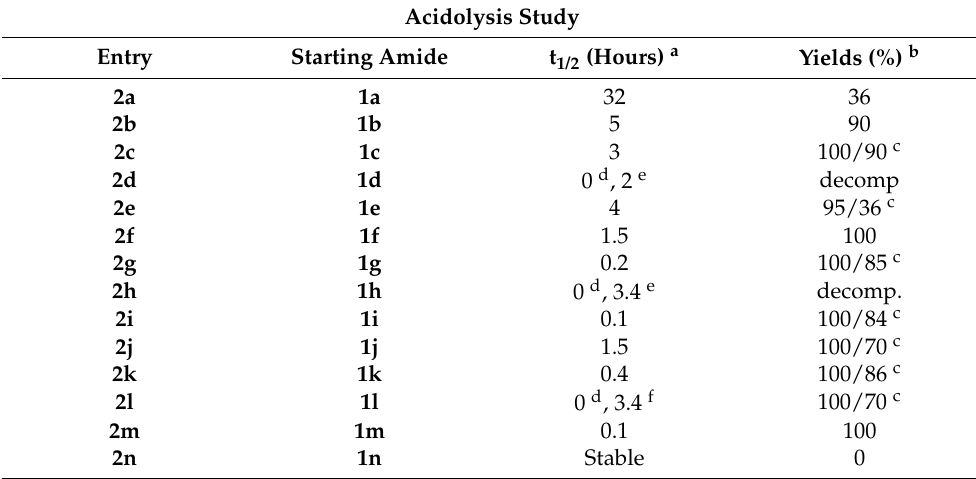
Table 1. Acidolysis